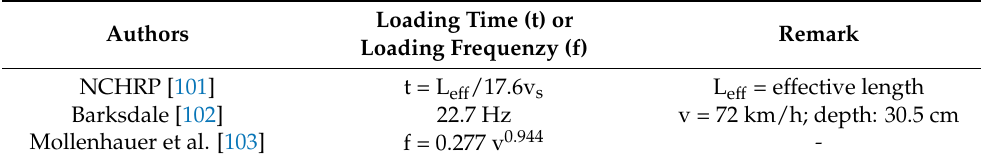
Table 3. Relationship between vehicle speed and loading time ( t ) or loading frequency ( f ).